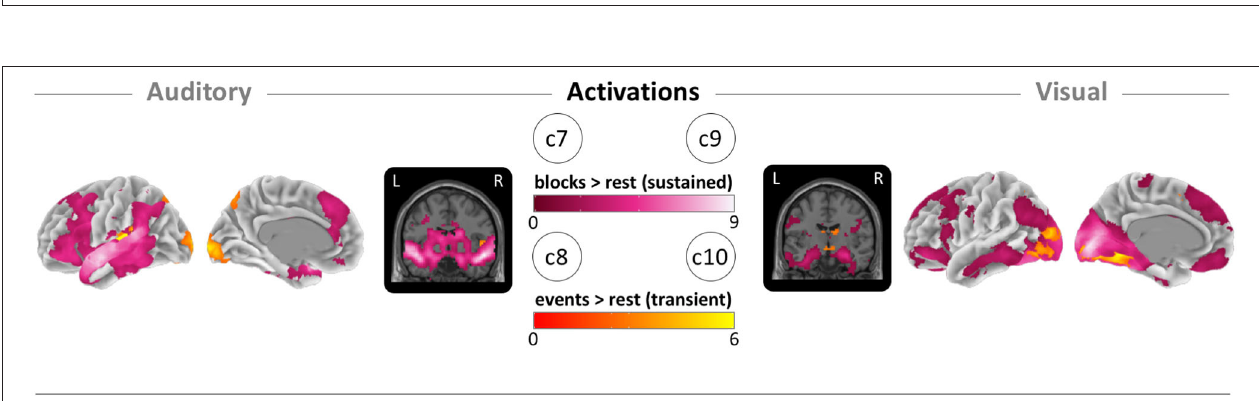
FIGURE 4 | Brain maps of sensory-unspecific encoding success activity (ESA), assessed through the contrasts between activity of subsequently remembered (hit) and subsequently forgotten (miss) stimuli of the isolated encoding condition. (c4) ESA across all conditions (auditory and visual). (c5) ESA of auditory stimuli. (c6) ESA of visual stimuli. Brain activity is shown at a threshold of p < 0.05 [false discovery rate (FDR) corrected], and the color intensity shows the t -value. Contrast maps are uploaded under https://neurovault.org/collections/IABCOPVN/.